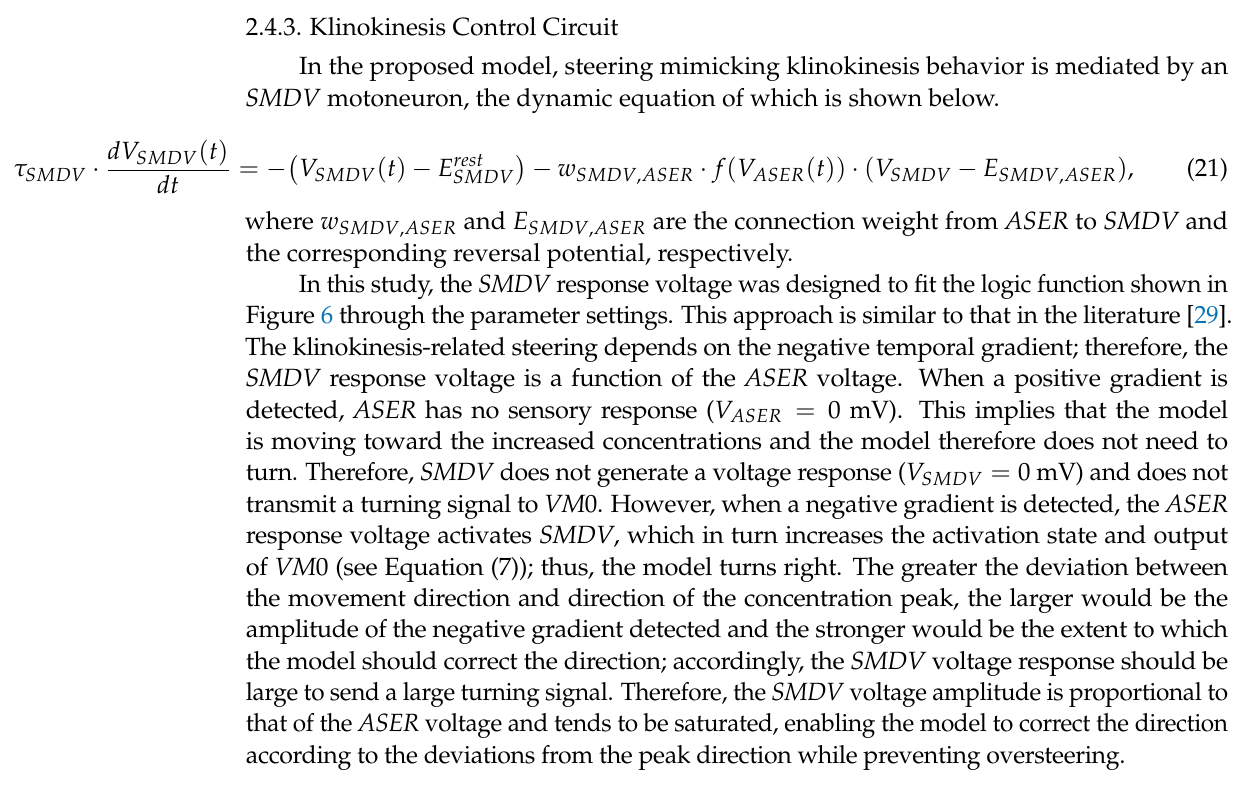
Figure 5. Cumulative differences in D/VM 0 output induced by application of an up ( a ); or down ( b ) step at each locomotion phase, where phase points c and e , respectively, correspond to phases c and e in Figure 4. The black dashed lines represent the shape of the locomotion trajectory.